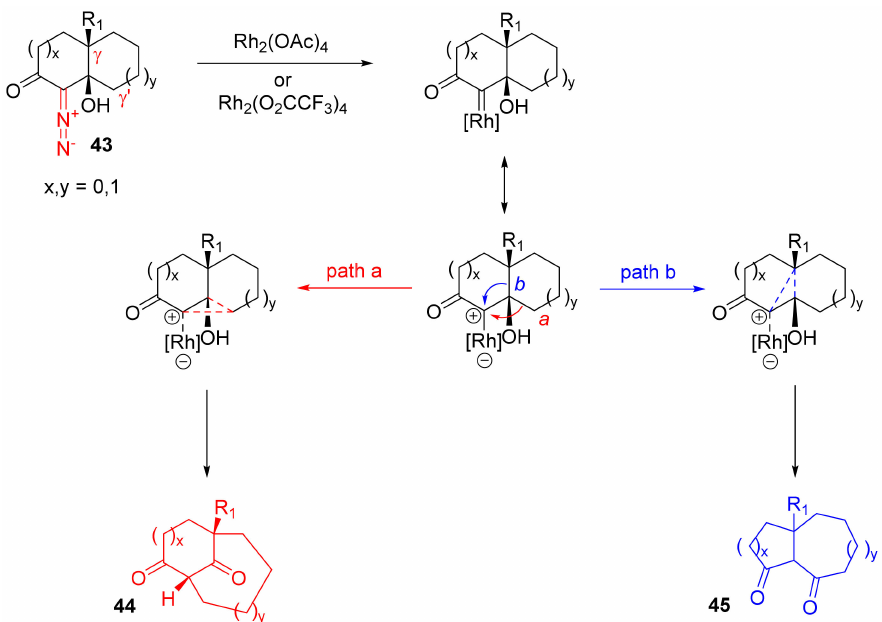
Scheme 28. Rh(II)-catalyzed Tiffeneau–Demjanov rearrangement towards cage products.